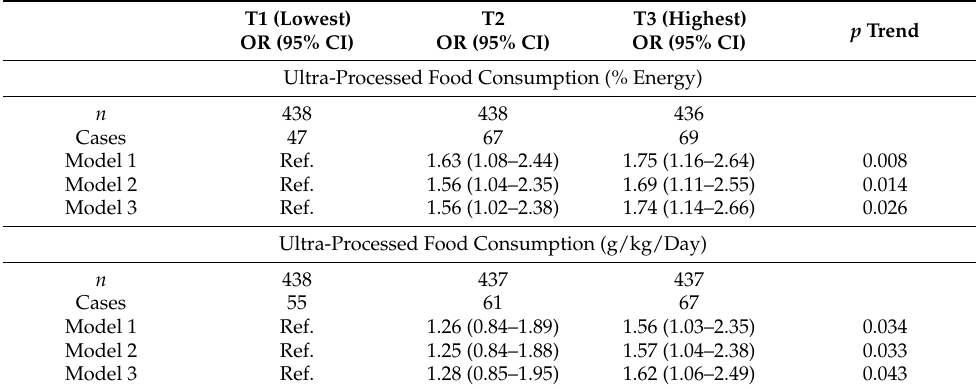
Table 2. Association between the consumption of ultra-processed food expressed as a percentage of total energy (% energy) or as grams per day/weight and the risk of renal function decline after 6-year of follow-up (2008/10–2015) ( n = 1312).